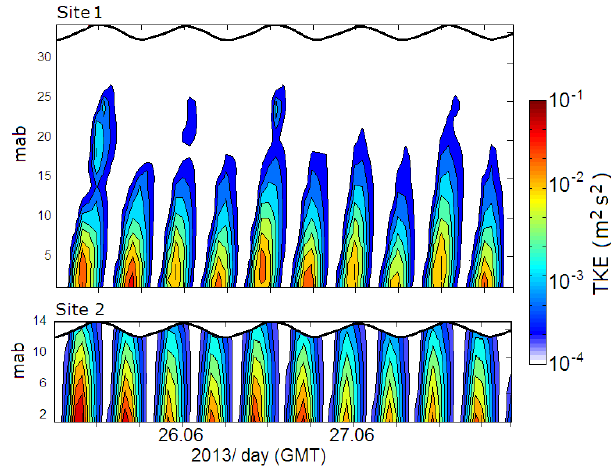
Figure 10. Distribution of TKE destruction by buoyancy, log 10 ( − P b ) , along transects A and B across the Wu and Zhuoshui rivers, respectively (Fig. 1). Tidal stages and tidal current directions on ebb (a, e) and on flood (c) for both transects are shown in the bottom right corners of the upper